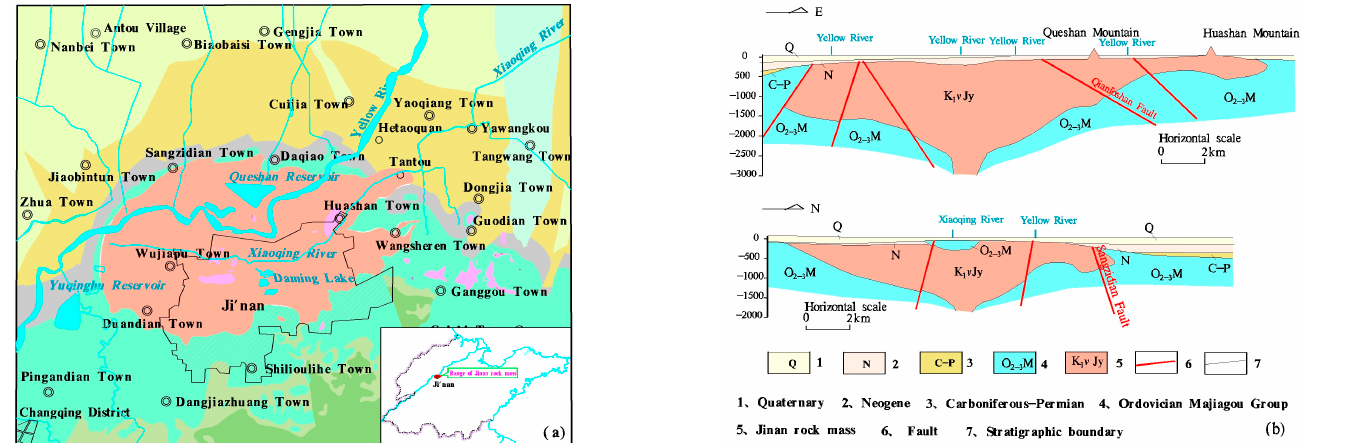
Figure 1. The geological background of the Ji’nan rock mass area. ( a )—The location and hydrogeo- logical conditions of Ji’nan rock mass area; ( b )—Plane and longitudinal profile of Ji’nan rock mass.